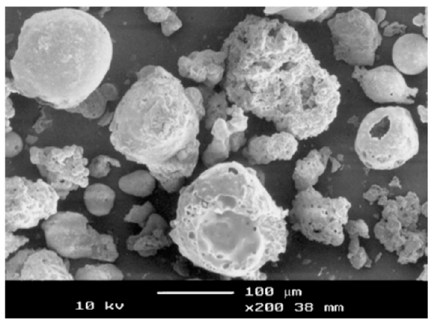
Figure 3. SEM micrograph of palm oil fuel ash [30].